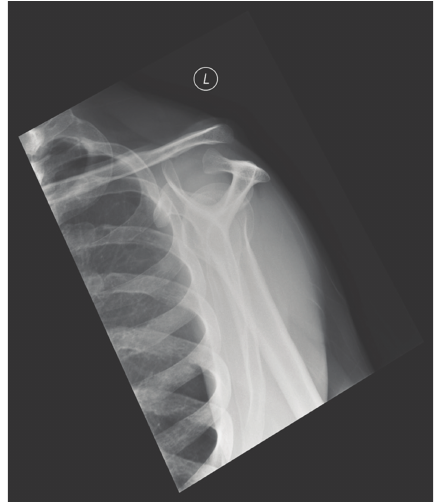
Figure6:Yradiographoftheleftshouldertaken3weeksafterinitial injury showing the dislocated acromioclavicular joint.